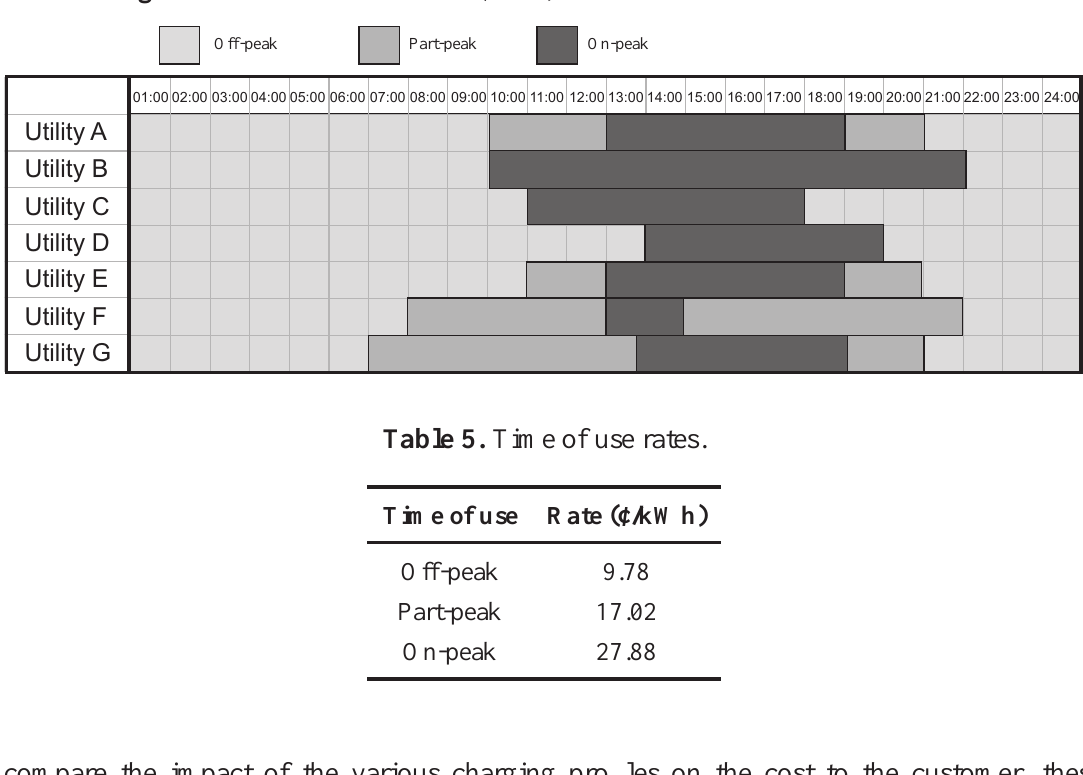
Figure 15. Tiered time of use (TOU) structures for several U.S. utilities.